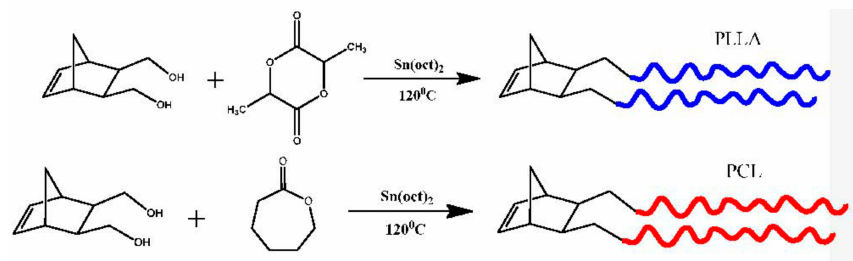
Figure 2. Synthesis of NBE-(PLLA) 2 and NBE-(PCL) 2 double macromonomers.